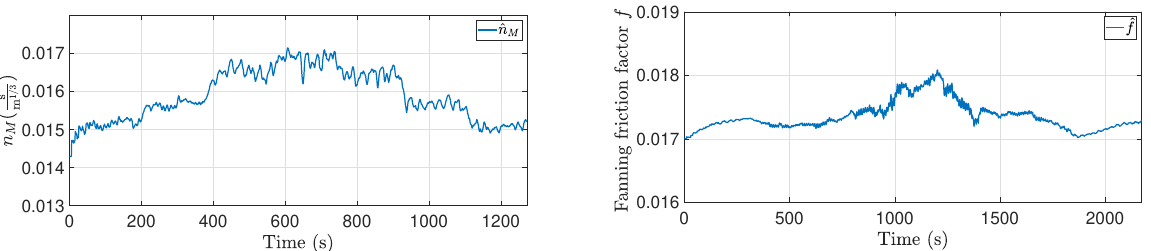
Figure 12: The reference Q r and estimated ˆ Q fluid flow rates for water.